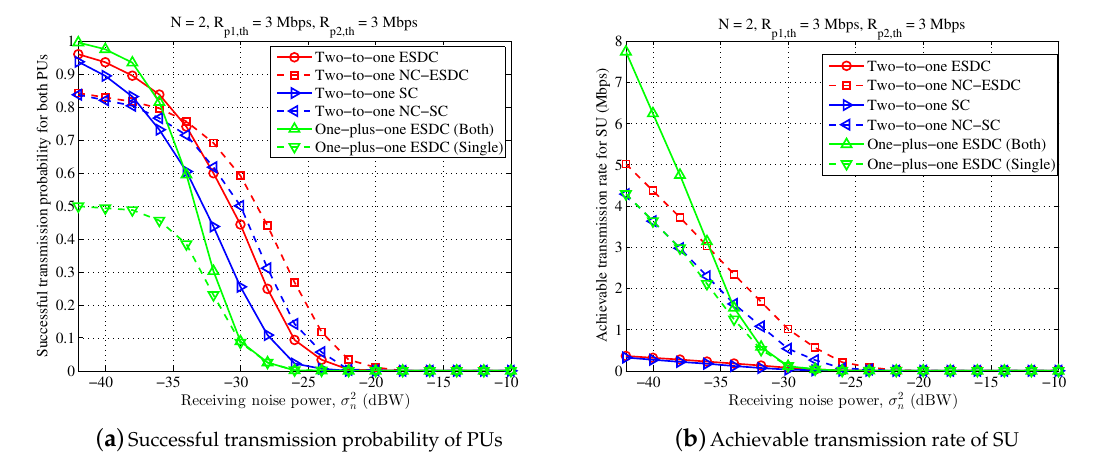
Figure 5. Performance comparison for different receiving noise power, in which n = 2, R p1,th = 3 Mbps, R p2,th = 3